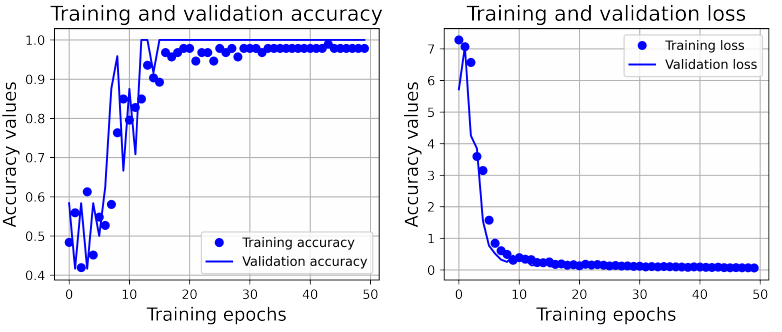
Figure 7. Charts of objects classification accuracy and the loss function value during the network training on the data in the second